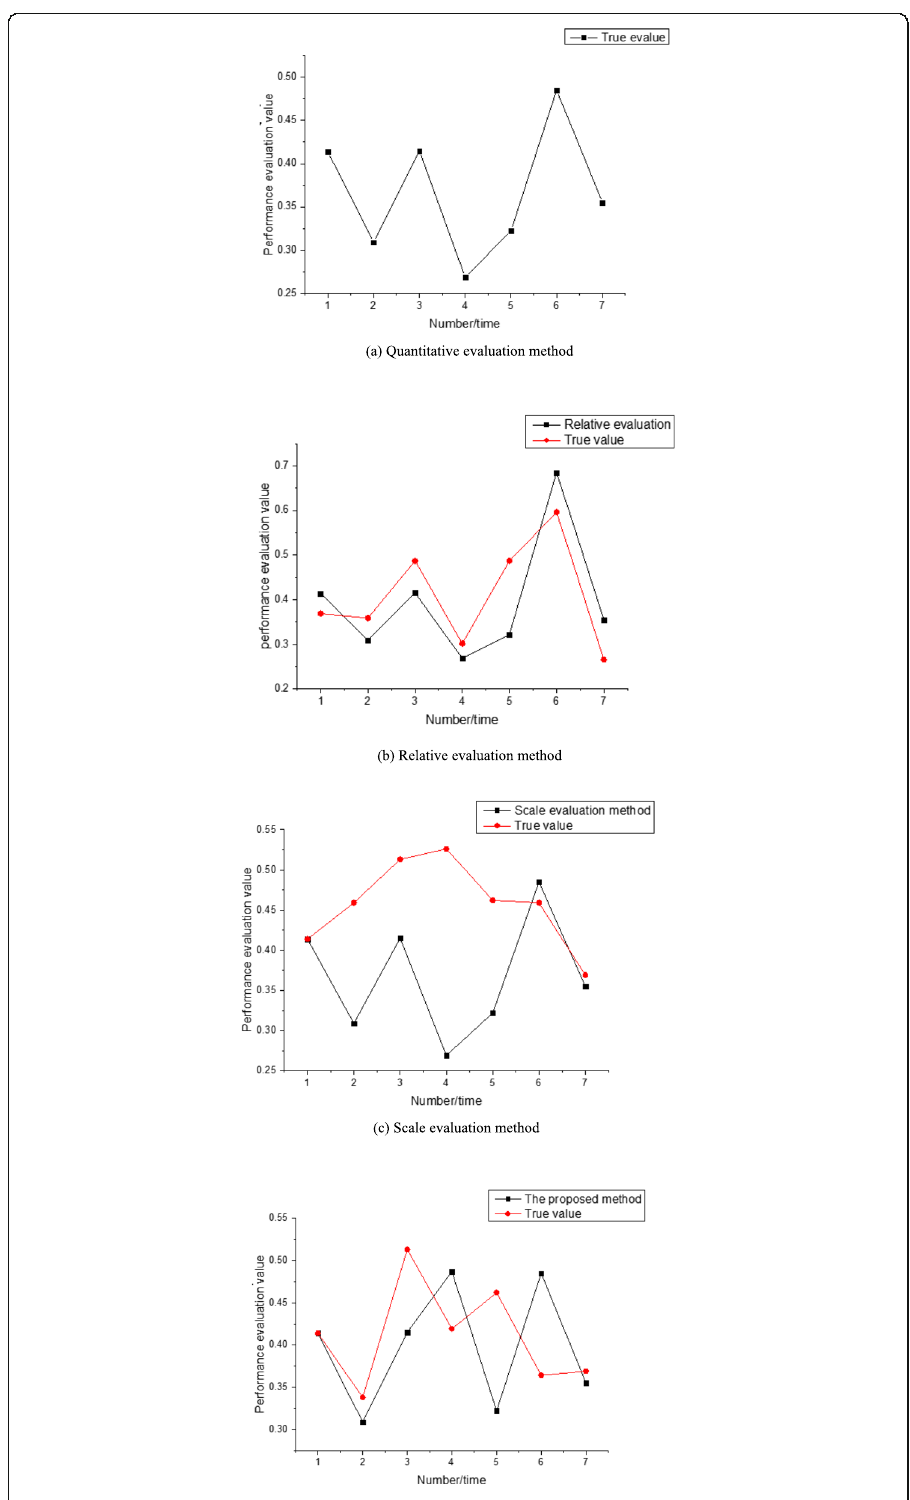
Fig. 5 Performance measurement comparison of different methods. a Quantitative evaluation method. b Relative evaluation method. c Scale evaluation method. d The proposed